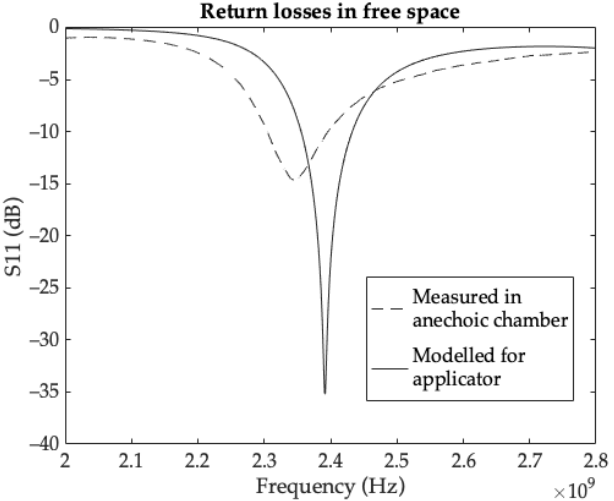
Figure 6. Comparison of the return losses (S 11 (dB)) between the model and the manufactured antenna, measured in an anechoic chamber.